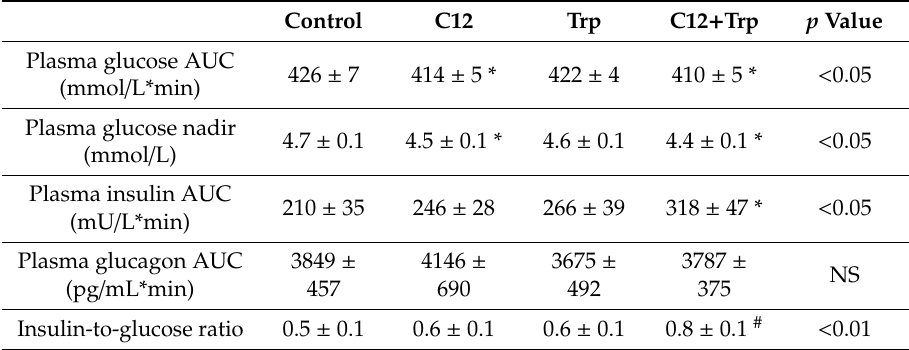
Table 1. Plasma glucose, insulin and glucagon concentrations, and insulin-to-glucose ratio during duodenal administration of lauric acid (“C12”; 0.3 kcal / min), L-tryptophan (“Trp”; 0.1 kcal / min), a combination of C12 and Trp (“C12 + Trp”; 0.4 kcal / min), or isotonic saline (“control”), for 90